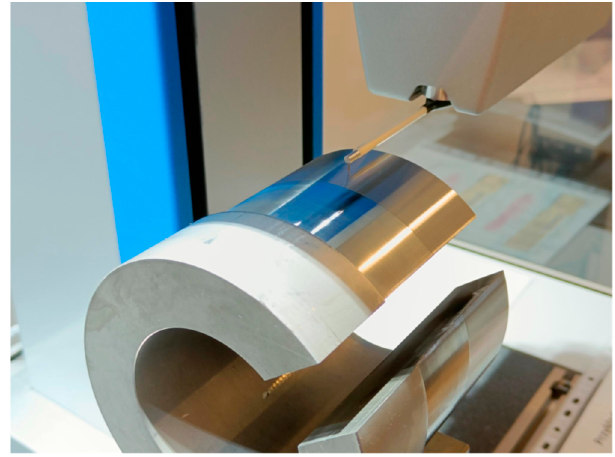
Figure 3. Measurement of the surface topography.